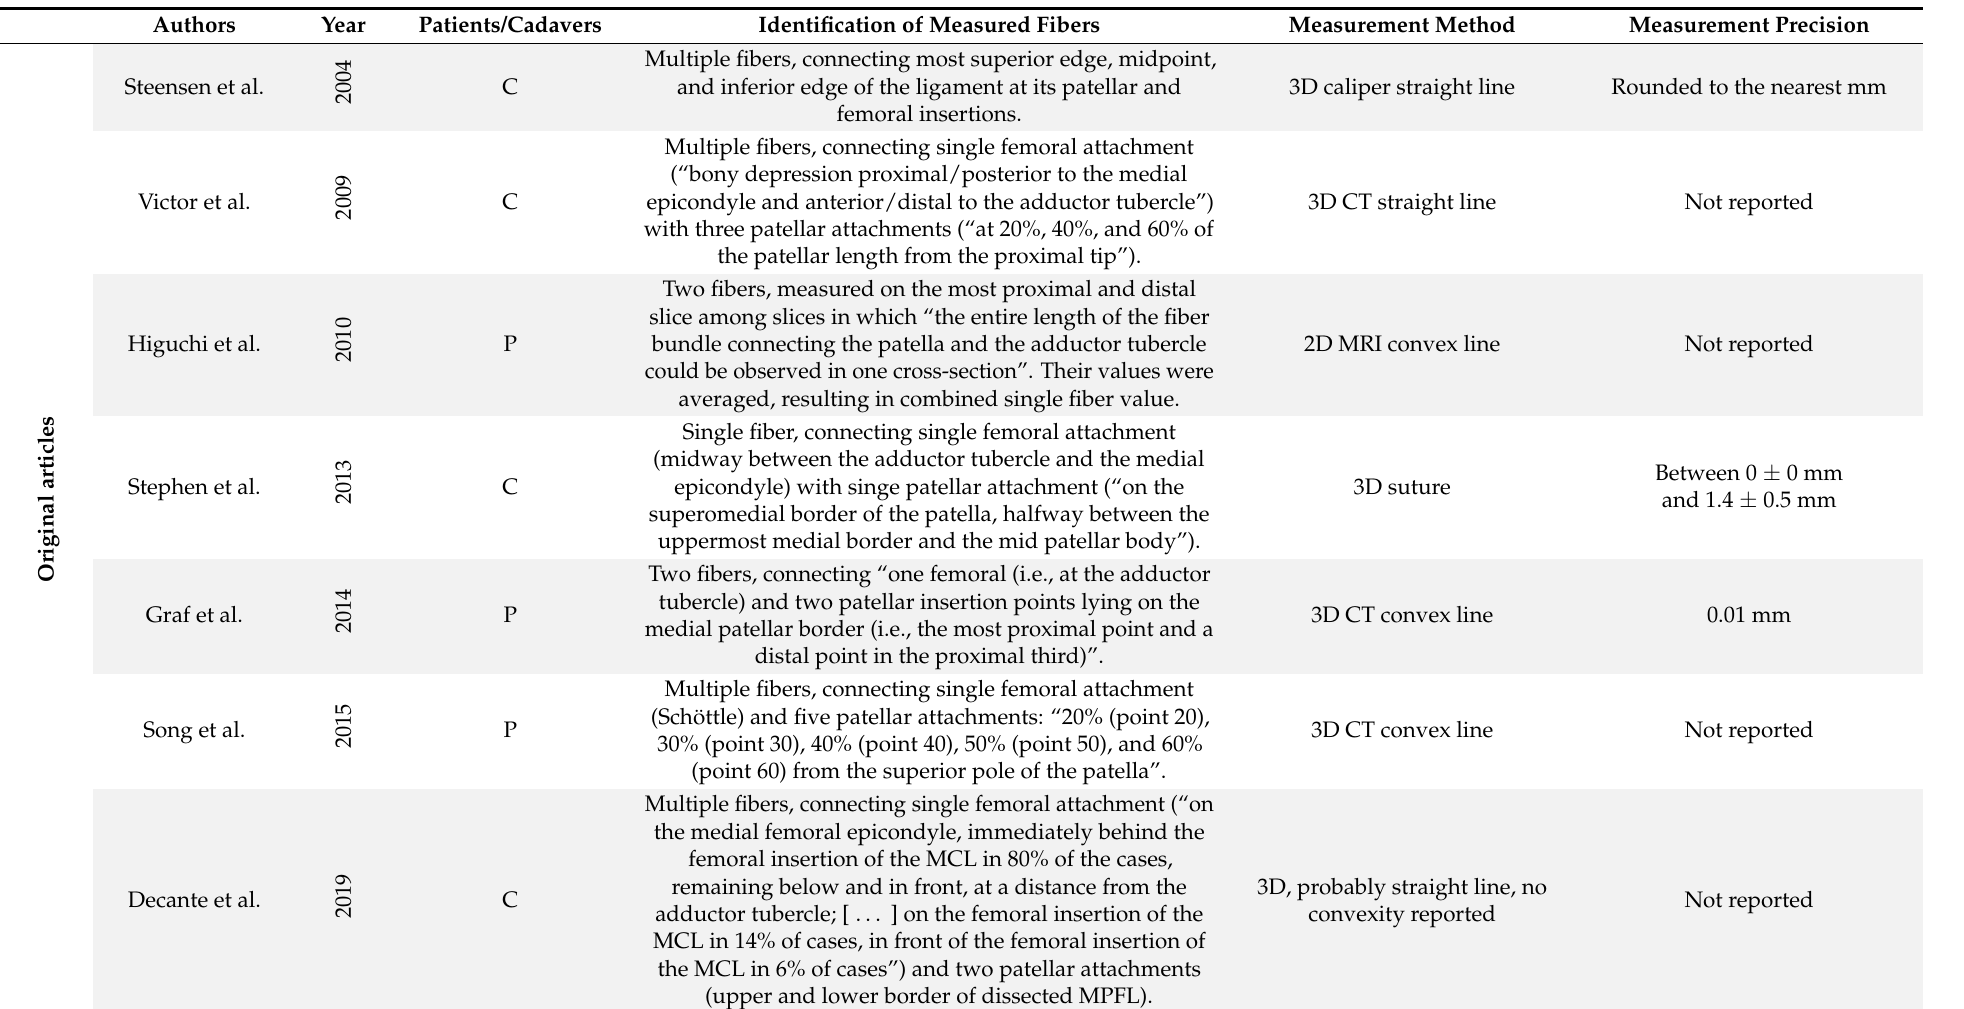
Table 2. Identification of measured fibers and measurement methods used in included